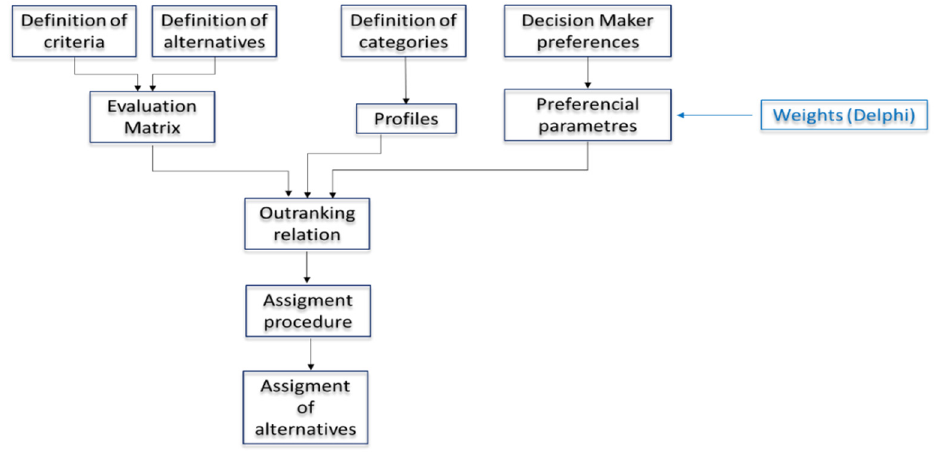
Figure 1. General scheme of the use of ELECTRE TRI.